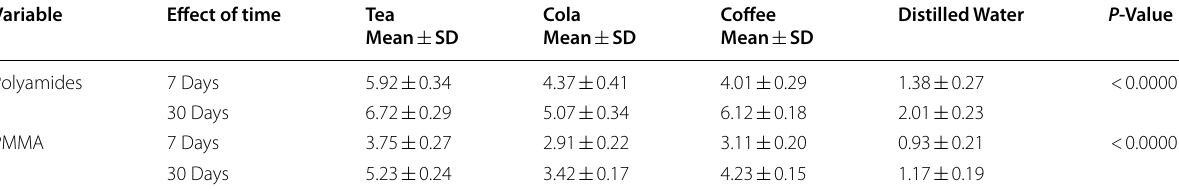
Table 1 Mean and Standard Deviation for Polyamides and PMMA